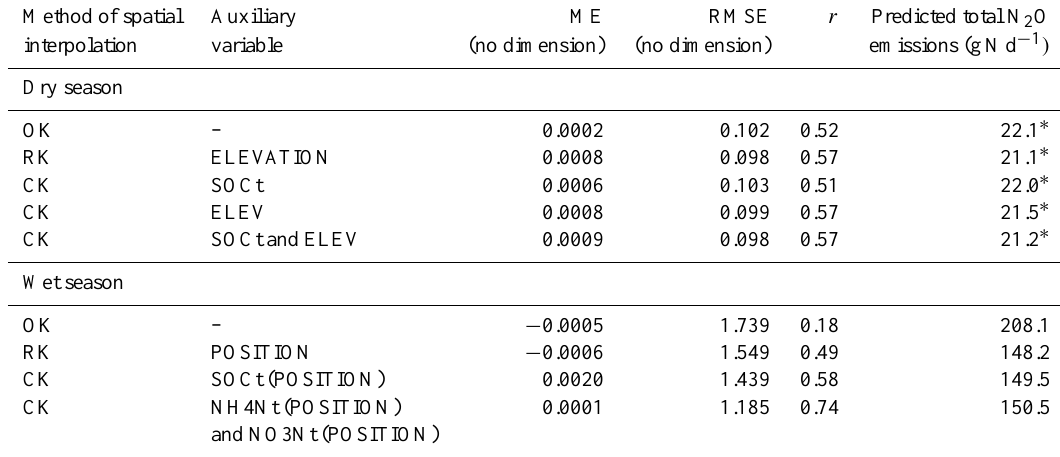
Table 4. Cross-validations of the three different kriging interpolations for N 2 O fluxes during the dry and wet seasons.